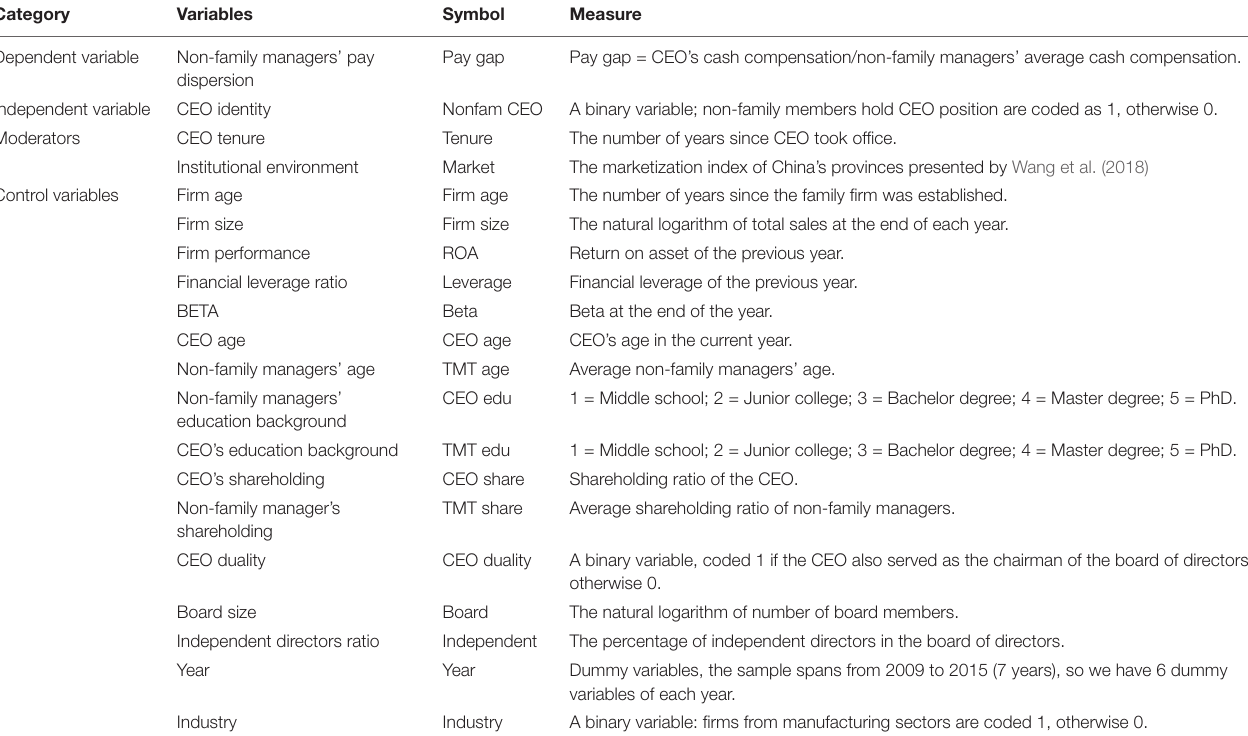
TABLE 1 | Variables summary.